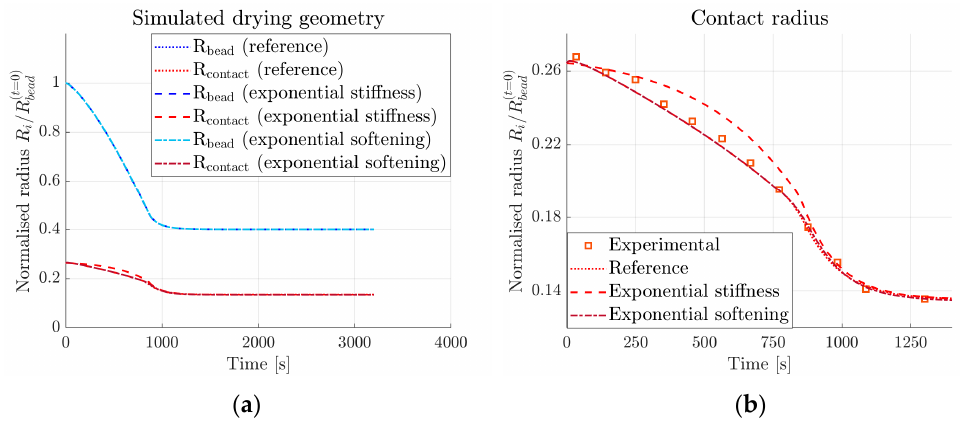
Figure 9. Simulation results for ( a ) bead and contact radii compared for reference simulations (as